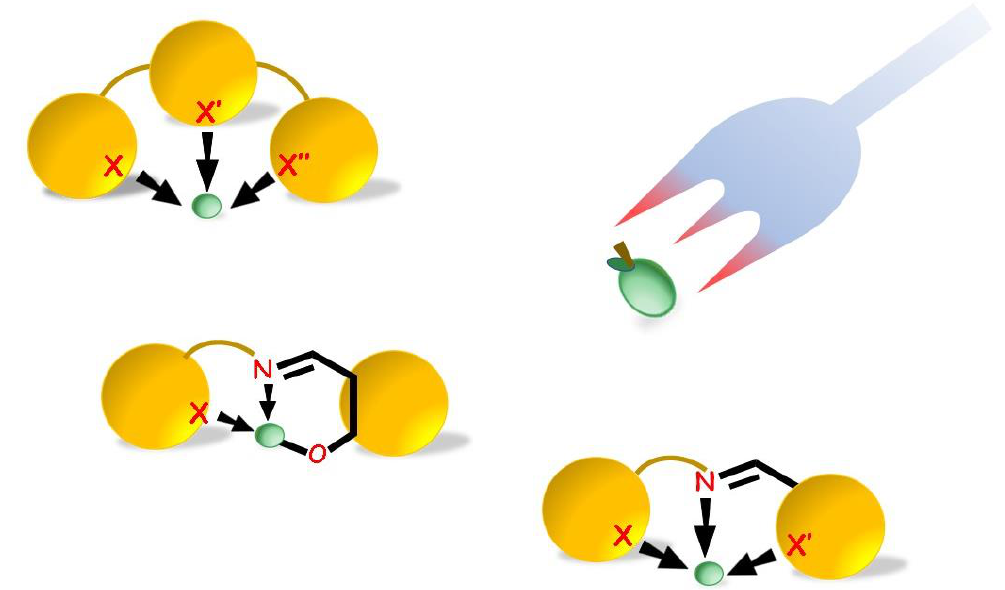
Figure 1. Schematic representation of most of the coordination cores achievable from tridentate pincers binding zinc(II) cation (in green). X, X′, and X″ can be N , O , and S atom groups.